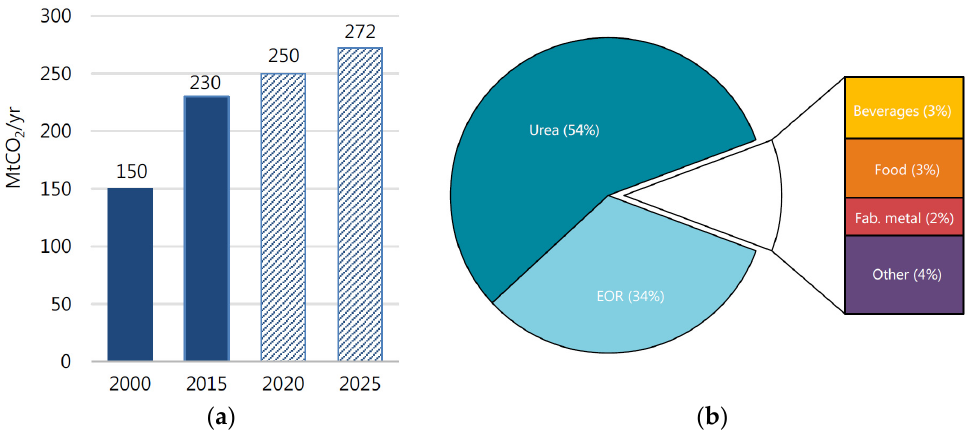
Figure 7. Forecast for CO 2 future global demand ( a ): average growth of 1.7% yearly; ( b ) 2015 demand by sector [33].